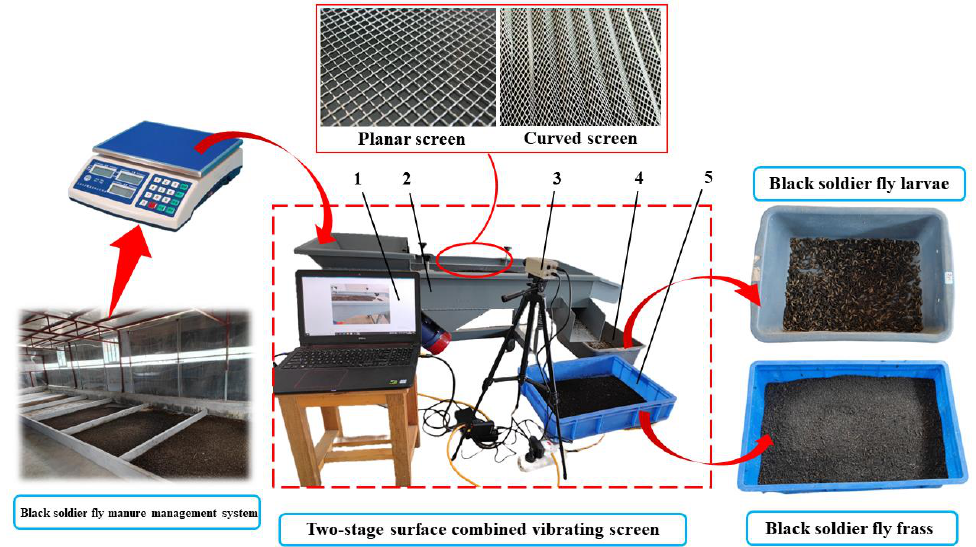
Figure 9. Platform for sorting test of black soldier fly sand mixture. 1. Computer; 2. Vibrating